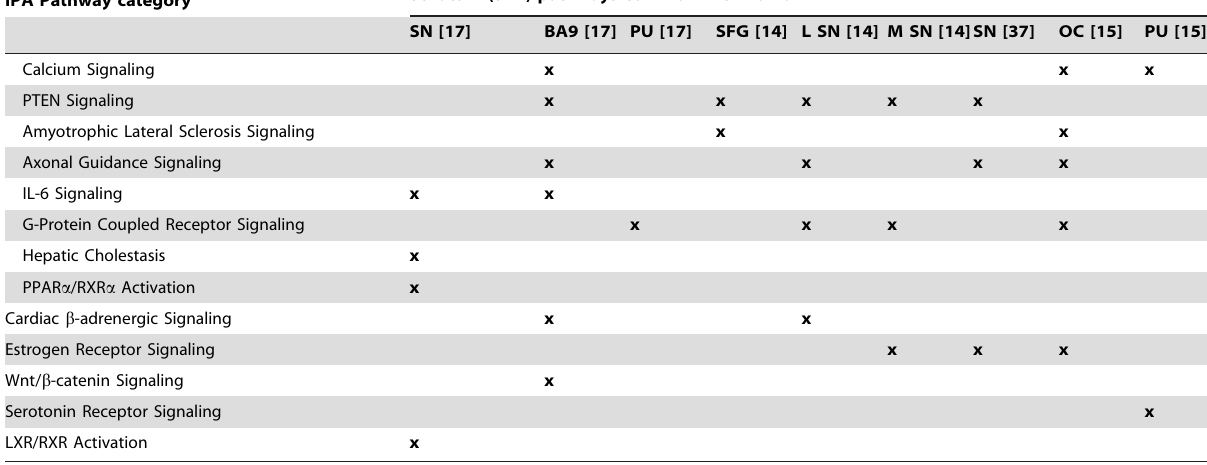
Table 3. Overlapping signaling pathways between human PD transcriptome studies and signaling pathways in STR of PQ, PY and MNPQ mouse models of